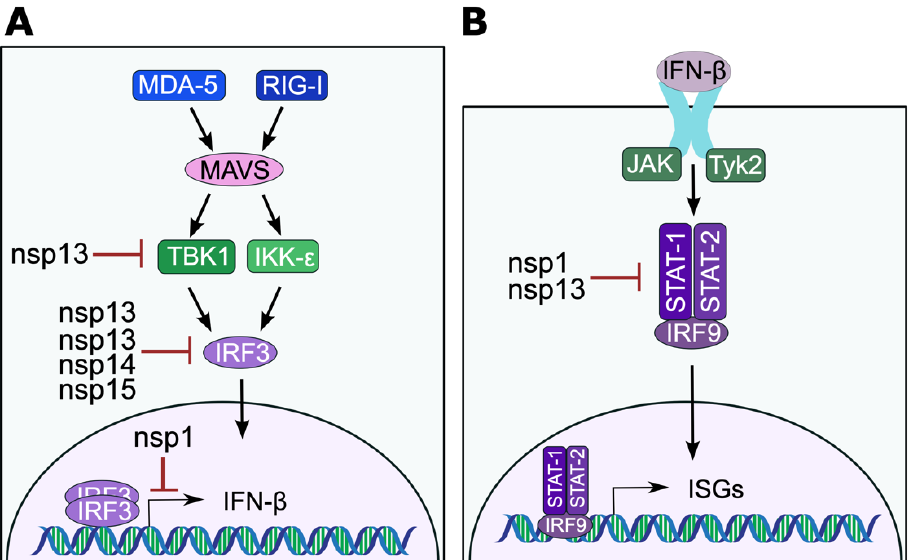
Figure 3. Coronavirus evasion of IFN-induction and response pathways. ( A ) Coronavirus proteins that inhibit IFN-induction targeting TBK-1 or IRF3 protein or transcription of IFN- β. ( B ) Coronavirus proteins that inhibit STAT1/2 in the IFN-response pathway.